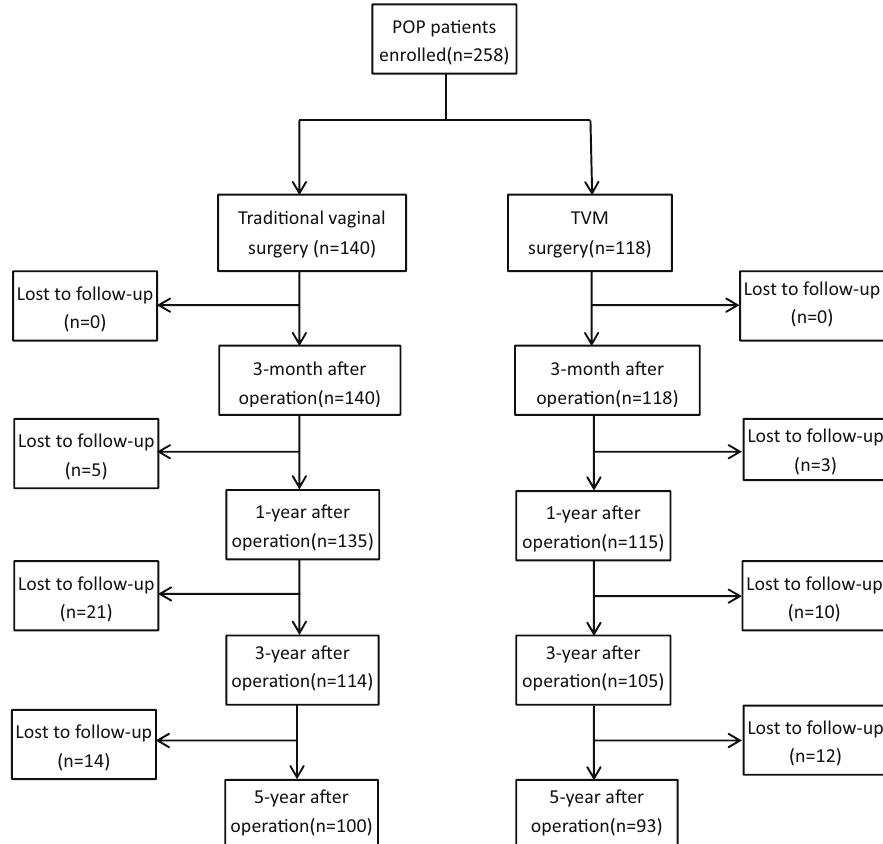
Figure 1: Flow chart of follow -